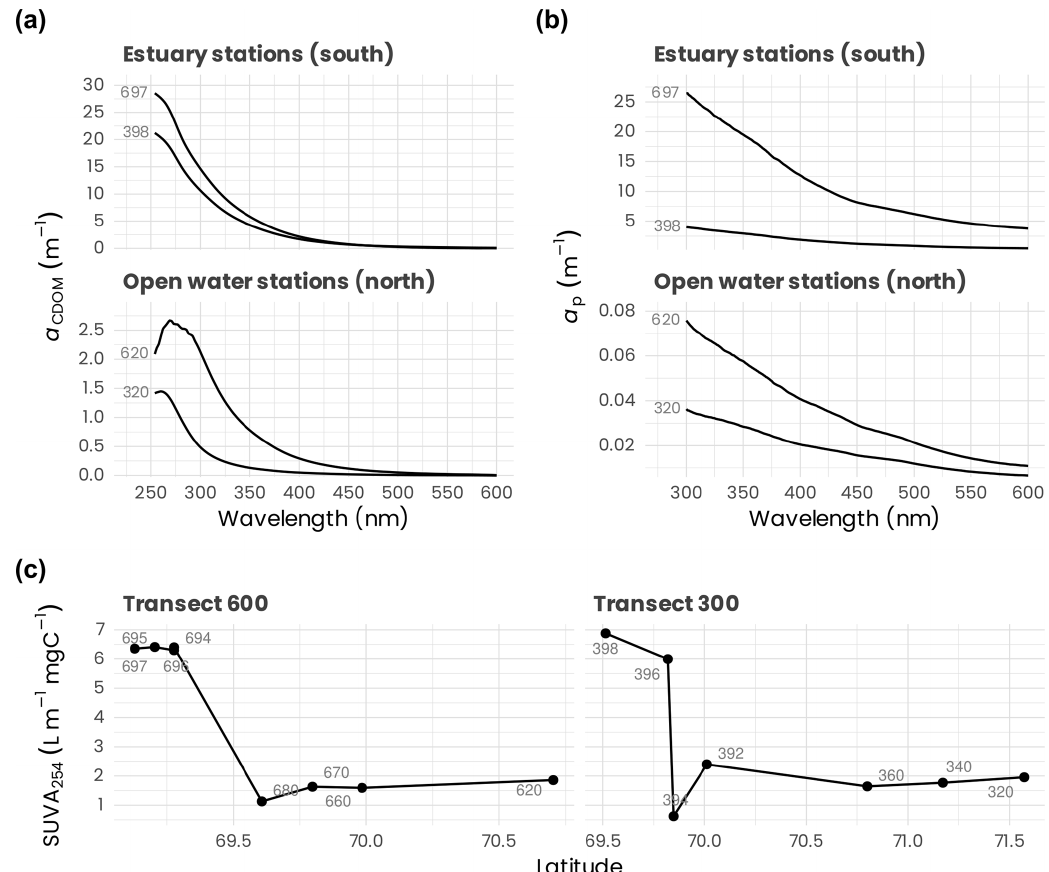
Figure 7. (a) Absorption spectra between 254 and 600nm of chromophoric dissolved organic matter ( a CDOM ) measured at the surface for the northern (620, 320) and southern (697, 398) stations of the transects 600 and 300. (b) Particulate-absorption spectra ( a p ) measured between 300 and 600nm measured at the surface for the northernmost and the southernmost stations of the transects 600 and 300. (c) Specific UV absorbance at 254nm (SUVA 254 , i.e., absorption of light at 254nm per unit of carbon) at surface for stations along transects 600 and 300. Stations are identified in light gray (see Fig. 1 for an overview of the station locations). Note the difference in the y axes used in panels (a) and (b) , which highlights the important differences in dissolved and particulate absorption between stations in the estuary and those